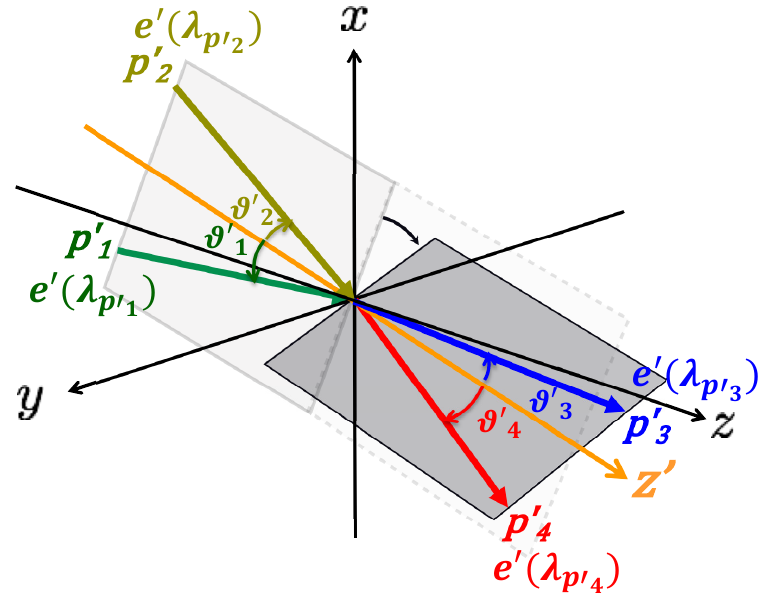
Figure 2. Relation between theoretical coordinates with the primed symbol and laboratory coordi- nates to which laser beams are physically mapped. The z (cid:48) -axis is theoretically obtainable so that stochastically selected two incident photons satisfying the resonance condition have zero pair trans- verse momentum ( p T ) with respect to z (cid:48) . The Lorentz invariant scattering amplitude is calculated on the primed coordinates where rotation symmetries of the initial and final state reaction planes around z (cid:48) are maintained. Definitions of four-momentum vectors p (cid:48) and four-polarization vectors i ) with polarization states λ = 1,2) and final state ( i = 3,4) plane waves e (cid:48) ( λ p (cid:48) p (cid:48) i for the initial state ( i i are given. This figure is extracted from